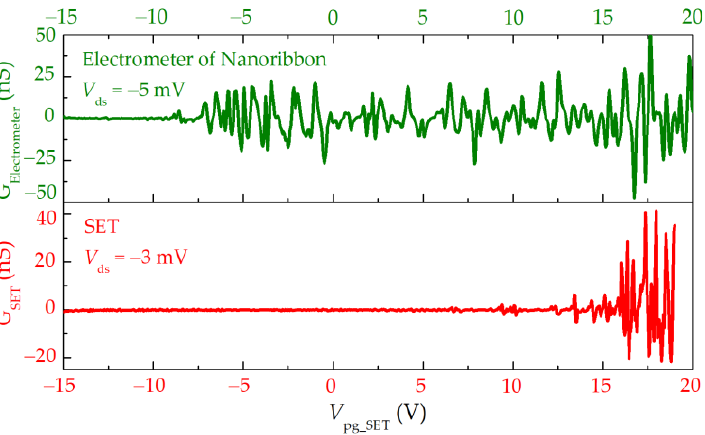
Figure 8. Comparison diagram of conductance curve of quantum-dot – nanostrip-integrated device.